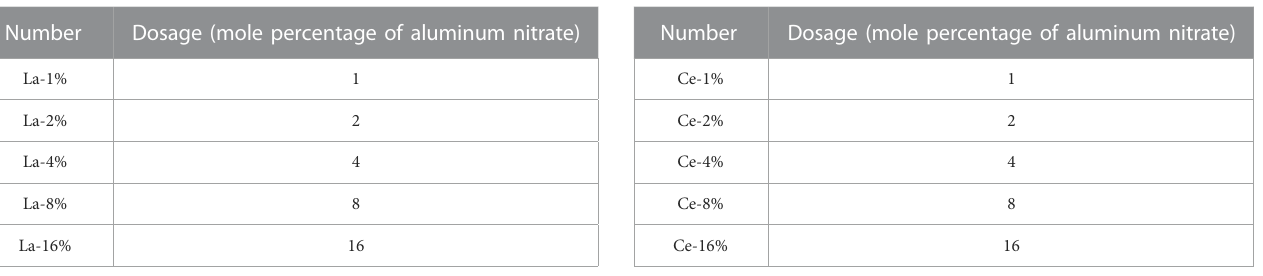
TABLE 2 Experimental formula of different amounts of lanthanum nitrate. TABLE 3 Experimental formula of different addition amounts of cerium nitrate.